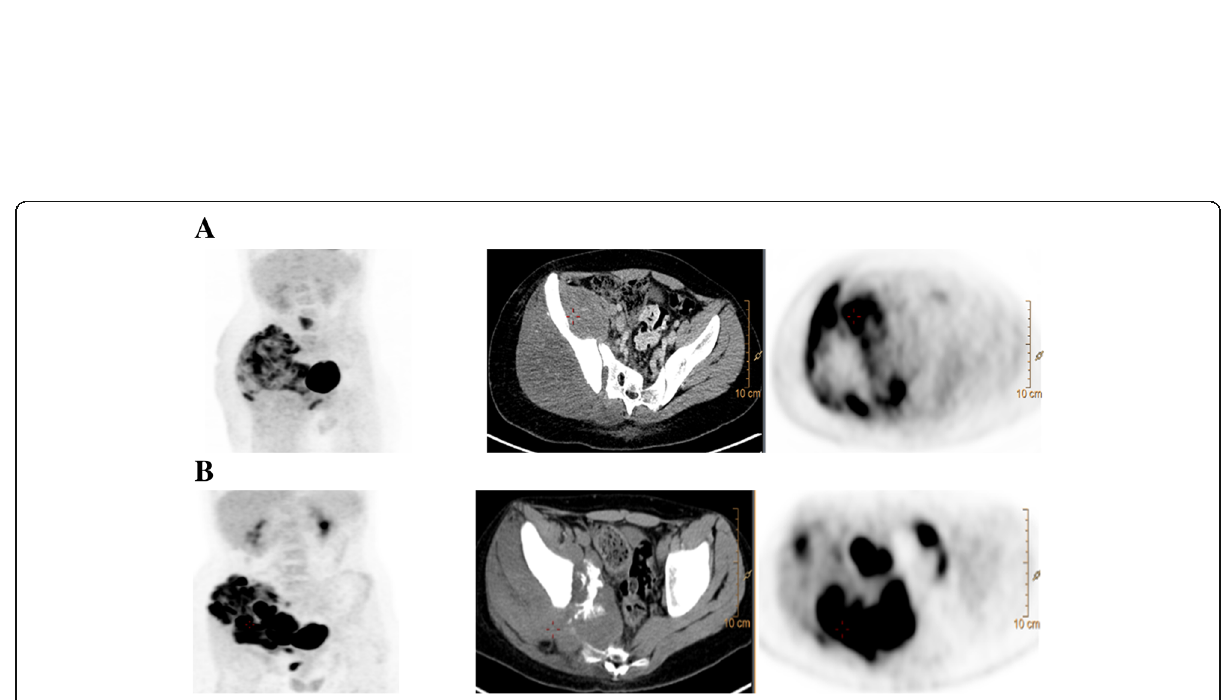
Fig. 6 A 16-year-old male with right iliac bone osteosarcoma. a Prechemotherapy coronal PET, axial CT, and axial PET revealed high pathological FDG uptake (SUV = 12) at the primary tumor site. Postchemotherapy coronal PET, axial CT, and axial PET revealed disease progression regarding size and FDG avidity (20 in the study). Amputation was done and histopathology showed that there was 90% viable tumor (poor